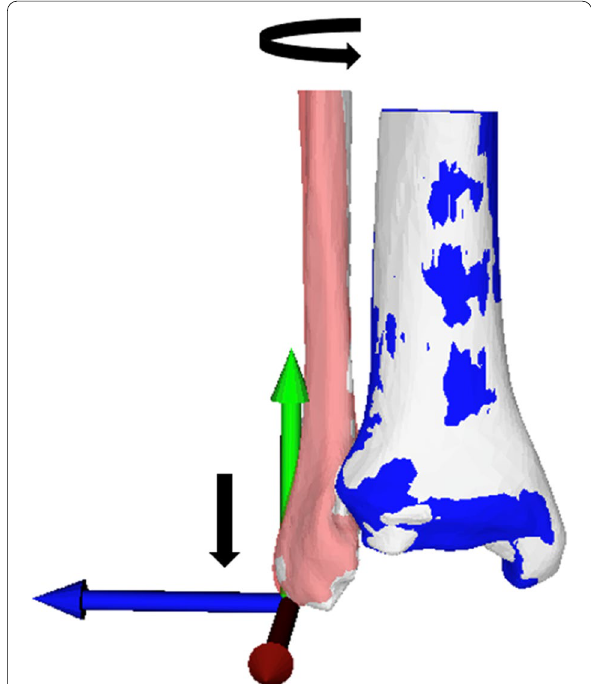
Fig. 3 25% tibia segment (blue, contralateral mirrored) to restore the distal fibula. The blue tibia is superimposed to the white ipsilateral tibia using the ICP method. Red fibula target ipsilateral fibula; white = fibula contralateral mirrored fibula. Using the 25% tibia segment as = a reference result in a distalization of the white contralateral fibula by 0.5 mm and an internal rotation of 0.6° −